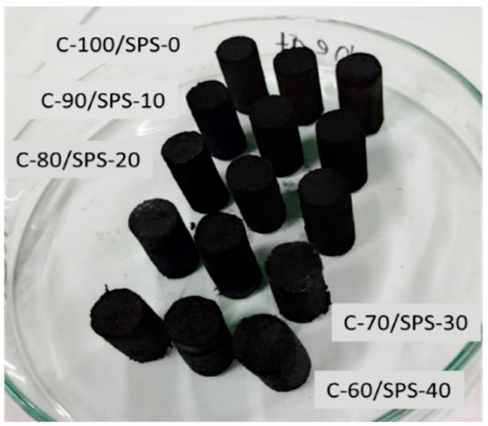
Figure 3. Biocomposite char briquettes via compression